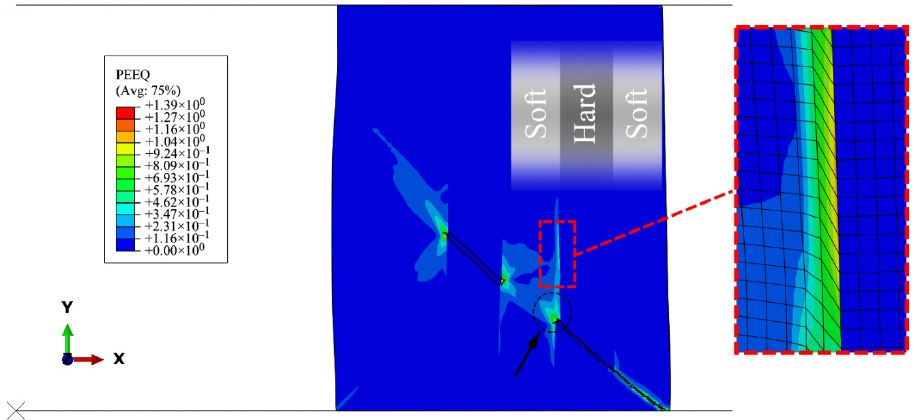
Figure 23. Secondary shear band at the interface of soft and hard materials in the 3by3 model before fracture, at the displacement level of d = 0.31 mm.